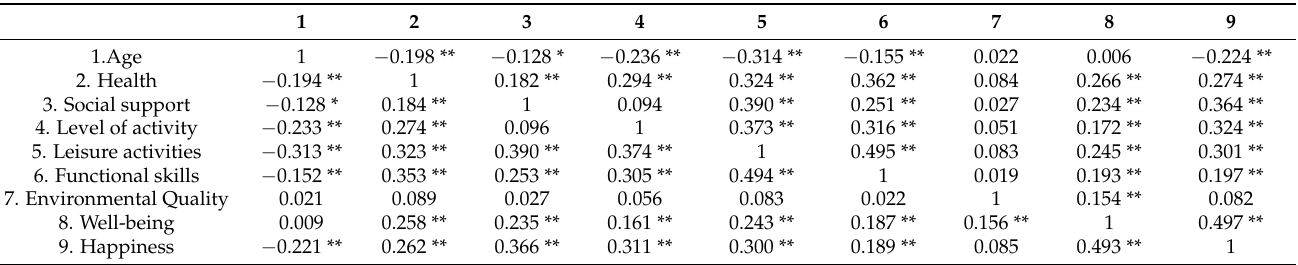
Table 3. Correlations between well-being and happiness with age and sex, health, social integration, activity level, leisure activities, functional skills and environmental